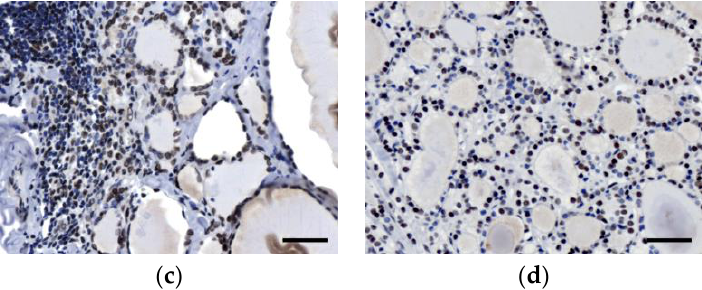
Figure 2. Immunohistochemical expression of integrase interactor 1 (INI1) in ( a ) normal thyroid tissue, ( b ) nodular goiter, ( c ) lymphocytic thyroiditis, and ( d ) follicular adenoma. Scale bars: 50 μm.